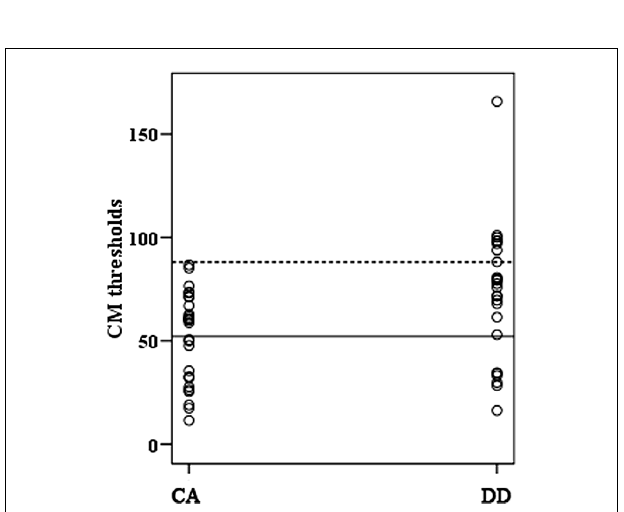
FIGURE 3 | Individual CM threshold in DD and CA groups. The solid line indicated the mean of CA group and the dashed line the chosen deviance threshold (1.65 SD above the mean of CA